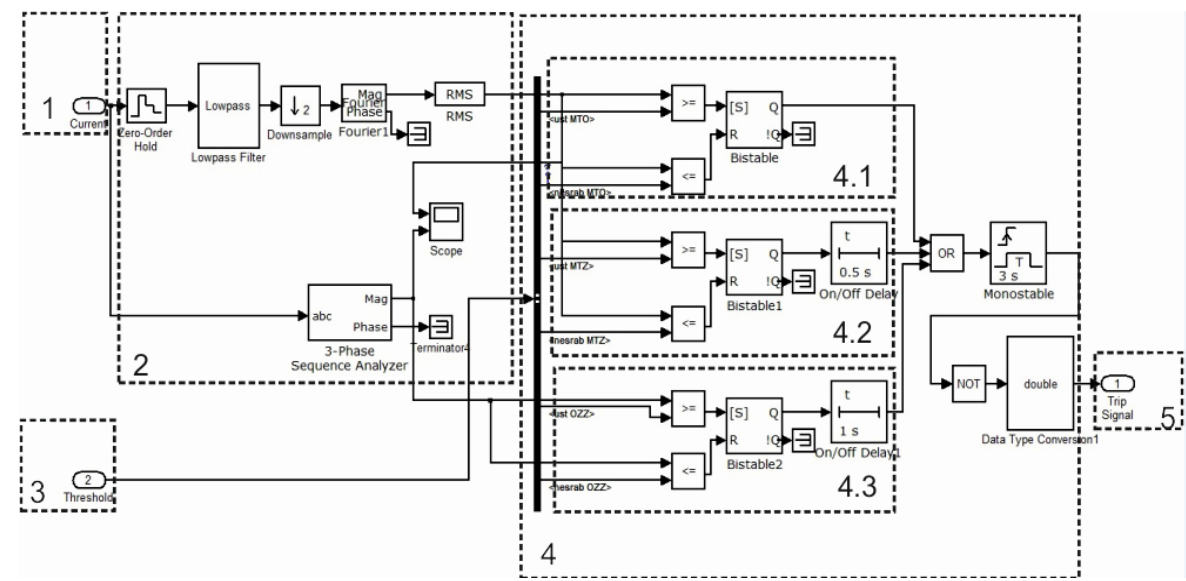
Figure 3. The simulation model of current protection devices: 1 –